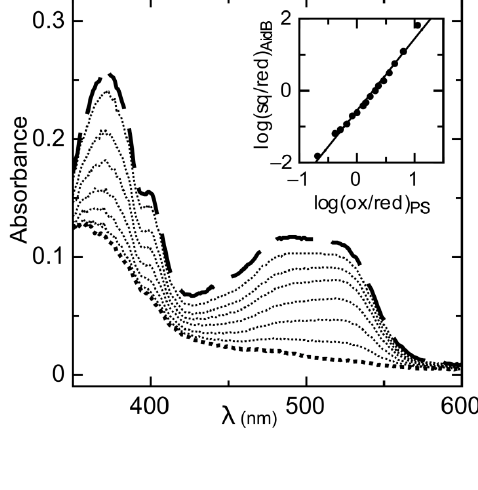
Figure 2. Simultaneous reduction of the AidB anionic semiquinone and PS. The visible absorbance spectra for the anionic semiquinone (monitored at 406 nm) and PS (monitored at 555 nm) decrease during their reduction. Inset: Plot of log [ox]/[red] for PS vs . log [sq]/[red] for AidB, used to calculate the midpoint potential with respect to the reference value of PS (−283 mV, pH